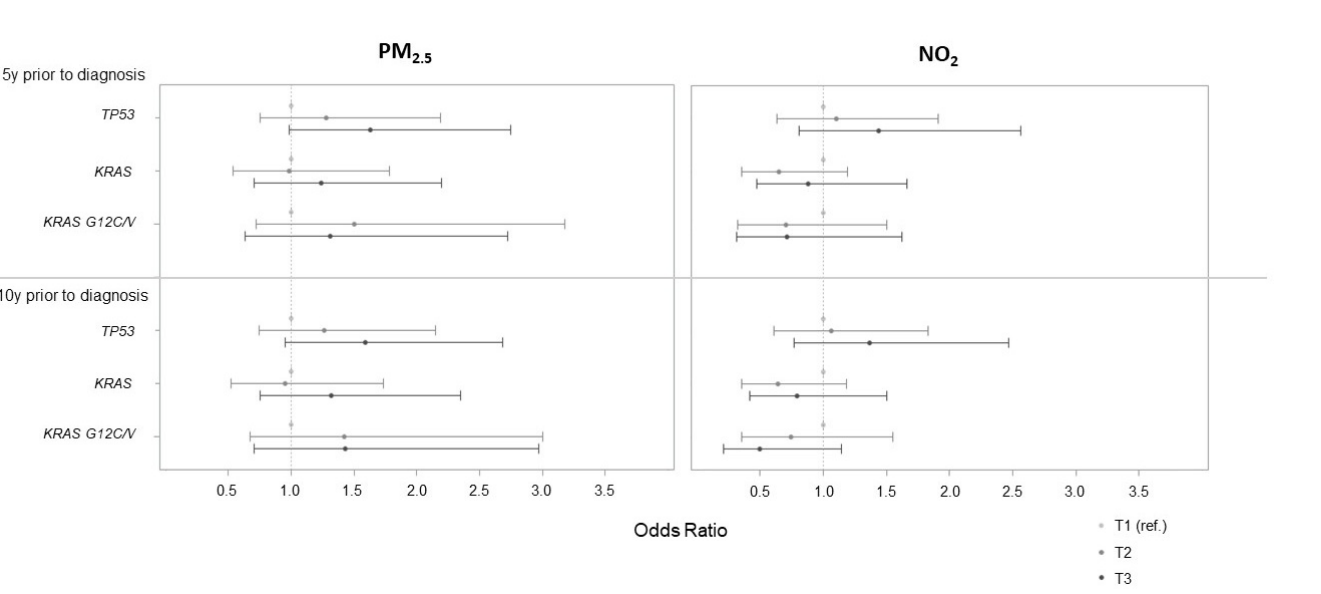
Figure 1. Associations between PM 2.5 and NO 2 categorized in tertile (assessed 5 and 10 years prior to cancer diagnosis) and lung cancer tumor mutations. Based on tertile distribution, PM 2.5 5 y prior to diagnosis was classified as [6.4;13.1], (13.1;15.0], and (15.0;19.6]; PM 2.5 10 y prior to diagnosis as